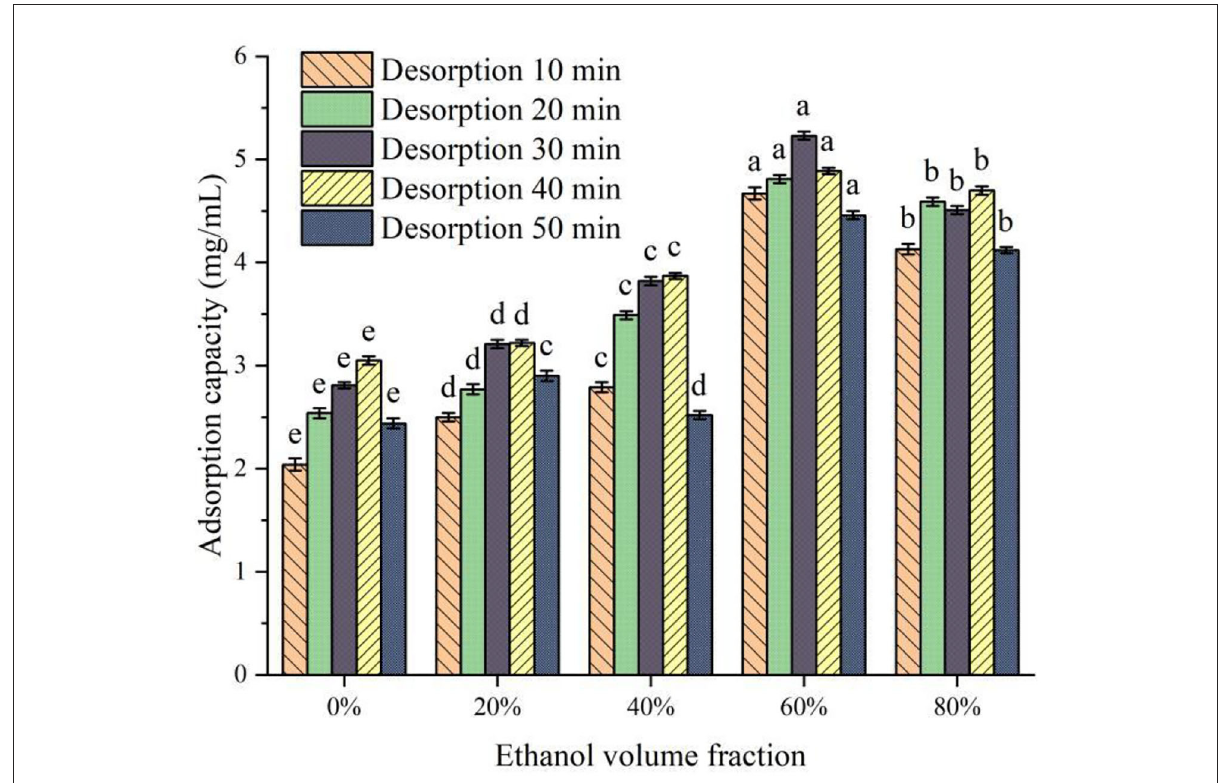
FIGURE3 Effect of ethanol solution with different volume fractions on desorption. There is a significant difference between different small letters ( P < 0.05).